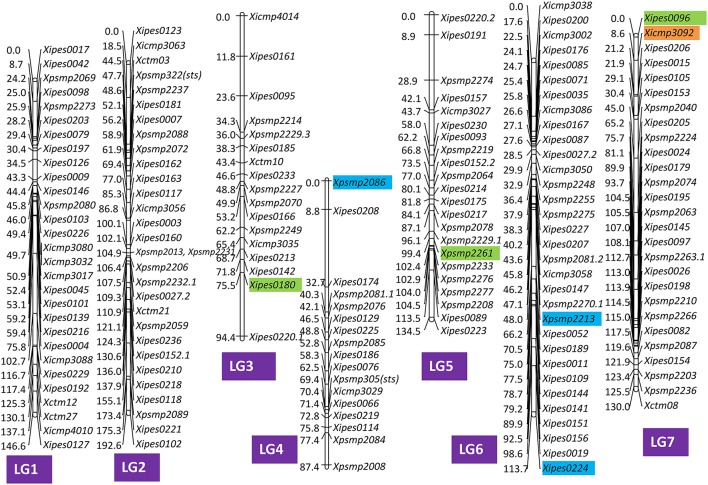
Genomic positions of significantly associated SSR markers with grain iron and zinc content in the consensus map of Rajaram et al. (2013). Color code: Orange for iron; Blue for zinc; and Green for both iron and zinc.